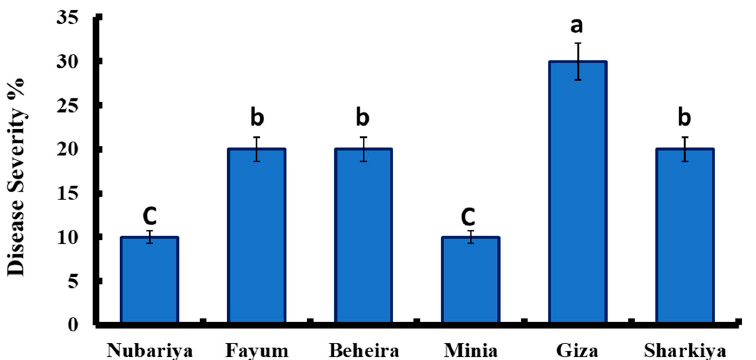
Figure 1. Disease severity percentage of H. maydis isolates from different Egyptian governorates. All values are presented as a mean of five replicates + SE. a,b,c Estimates with the same letters are not significantly different ( p ˂ 0.05).